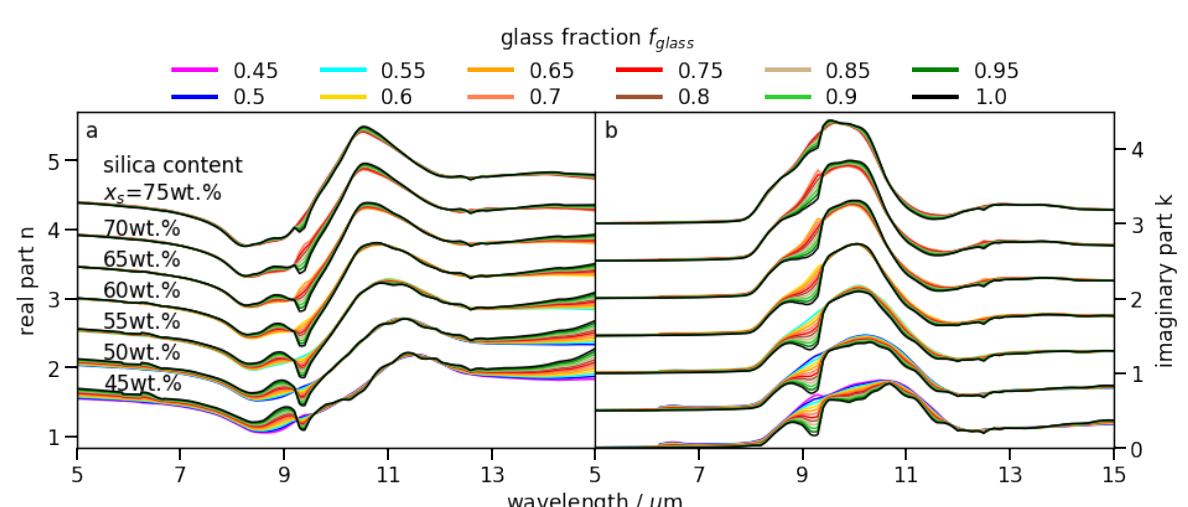
Figure 5. Real ( a ) and imaginary ( b ) parts of the complex refractive indices of the volcanic ash types derived by Piontek et al. [23]. Different glass fractions f glass are denoted by the color. For visibility reasons, different silica contents x s are shifted by 0.5 with respect to each other.